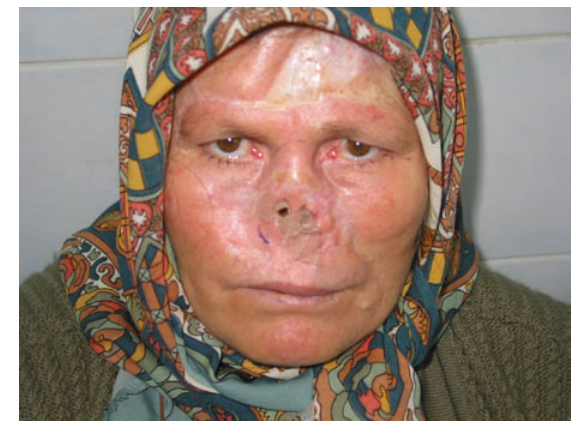
Figure 5. Case 2 before application.